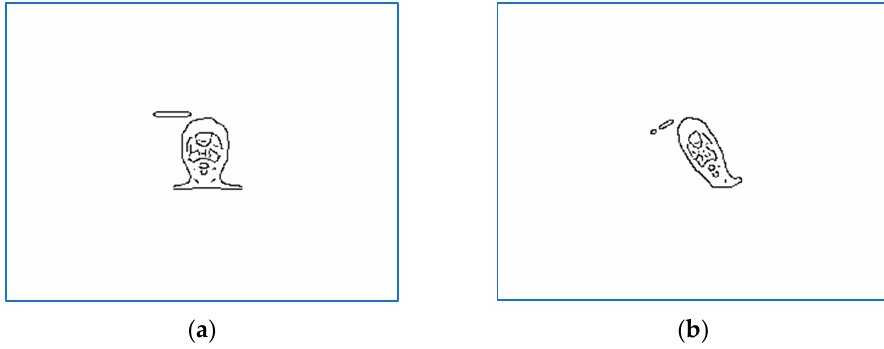
Figure 4. Images for subject 7, scaled and binarized, s1 = 4: ( a ) target; ( b ) sensed.